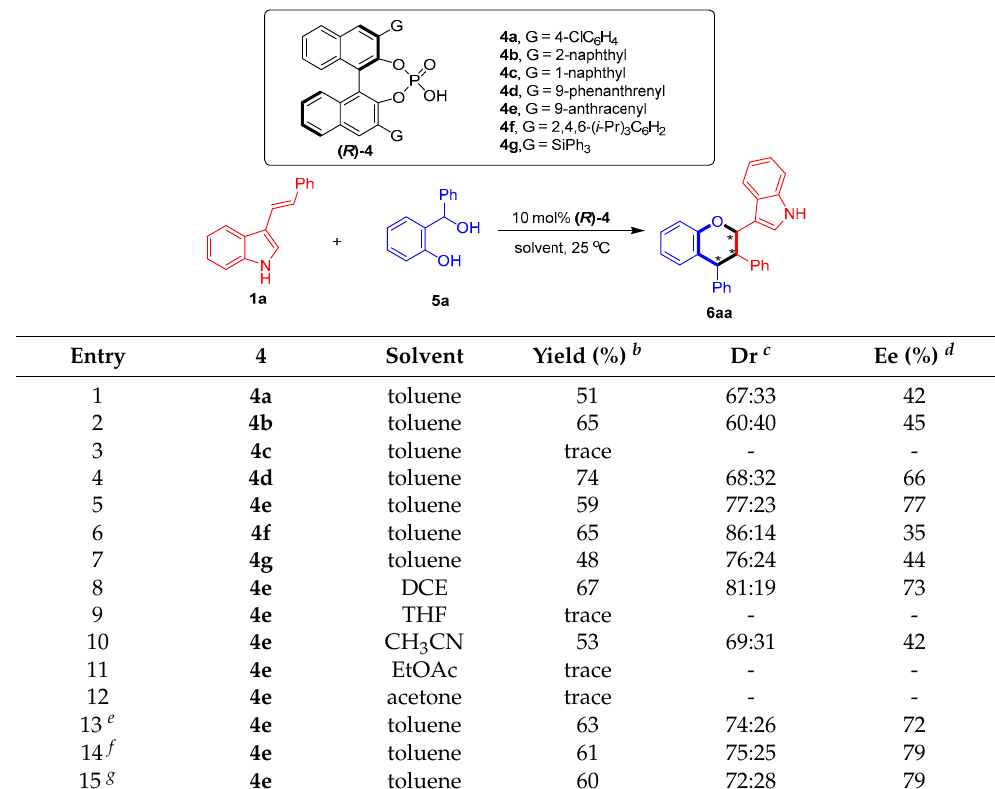
Table 5. Optimization of reaction conditions for [2 + 4] cycloaddition of 1a with 5a a .